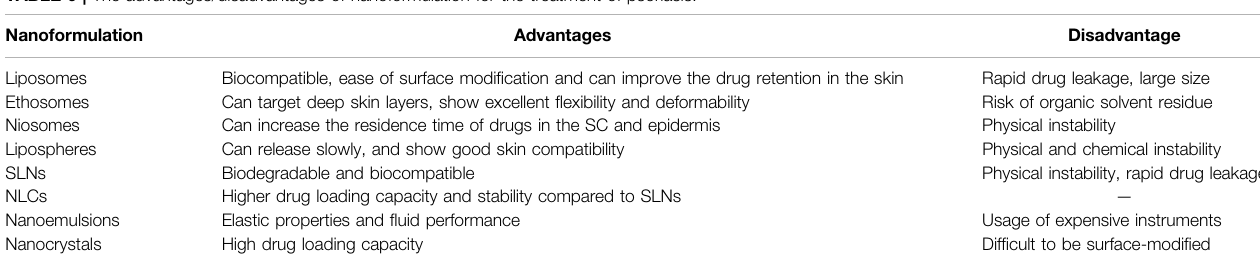
TABLE 6 | The advantages/disadvantages of nanoformulation for the treatment of